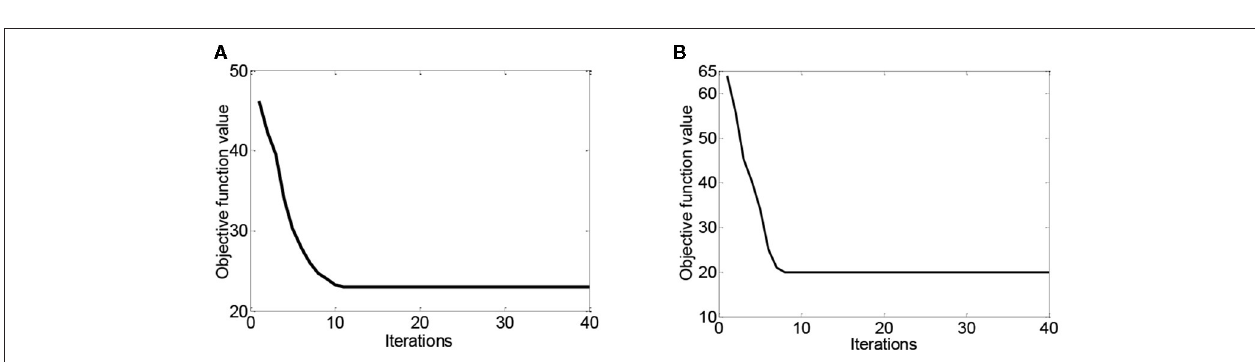
FIGURE 6 | The convergence curves of DASRC on two scenarios, (A) cross-subject on SEED, (B) cross-dataset on DEAP → SEED.